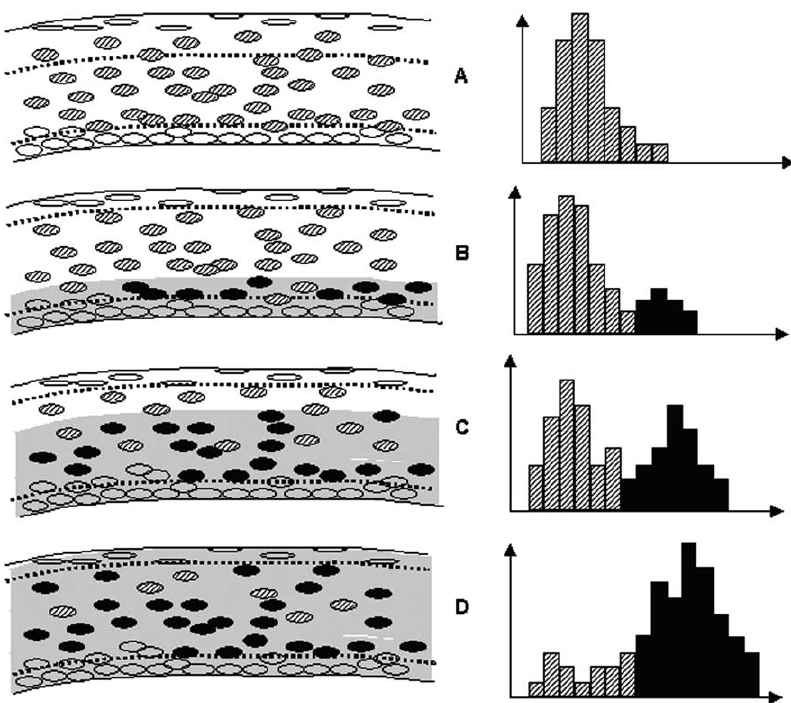
Fig. 5. Schematic illustration of the sampling process. A – Normal epithelium, D – CIN 3 epithelium. The two dashed lines delineate the sampling area, from which cells will be collected. White cells: not collected; dashed and black cells: collected. Dark cells represent cells with detectable nuclear abnormalities. As the number of “abnormal” move towards the surface of the epithelium, the proportion of collected abnormal cells increases. Such sampling reflects the dysplastic changes, while reducing the manual and subjective selection of cells http://www.esacp.org/acp/